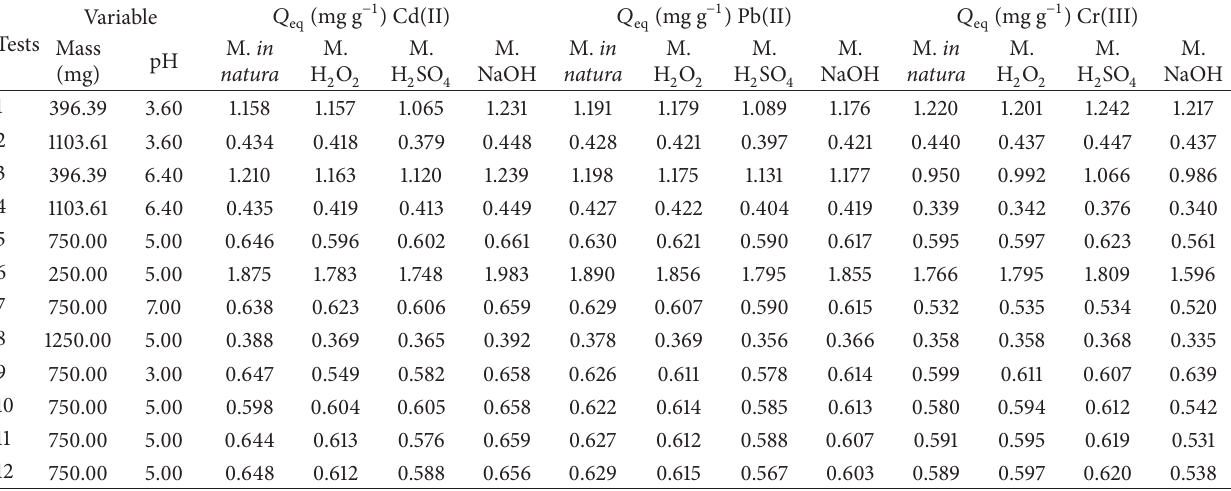
Table 3: Planning matrix CCRD with quadruplicate at the midpoint and average adsorption rates of Cd(II), Pb(II), and Cr(III) to adsorbents in natura and chemically modified with H 2 O 2 , H 2 SO 4 , and NaOH solutions.